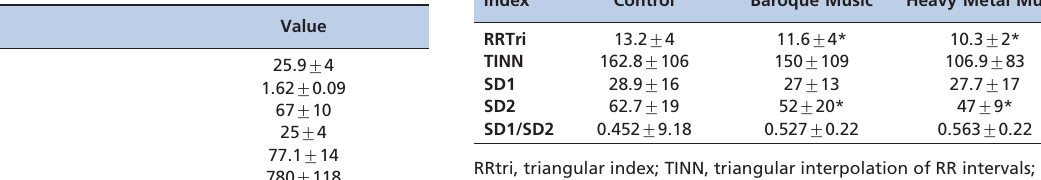
RRtri, triangular index; TINN, triangular interpolation of RR intervals; SDI, standard deviation of the instantaneous variability of the